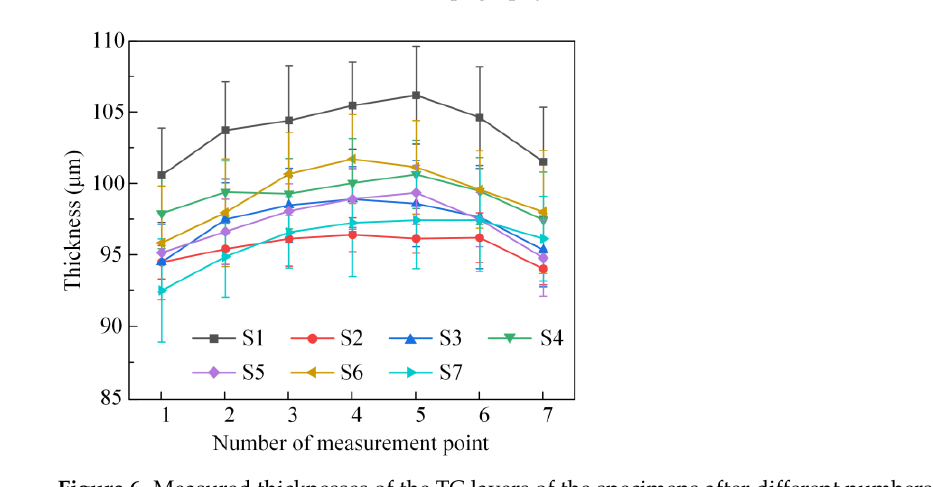
Figure 5. Measured results of surface topography scans of S1.